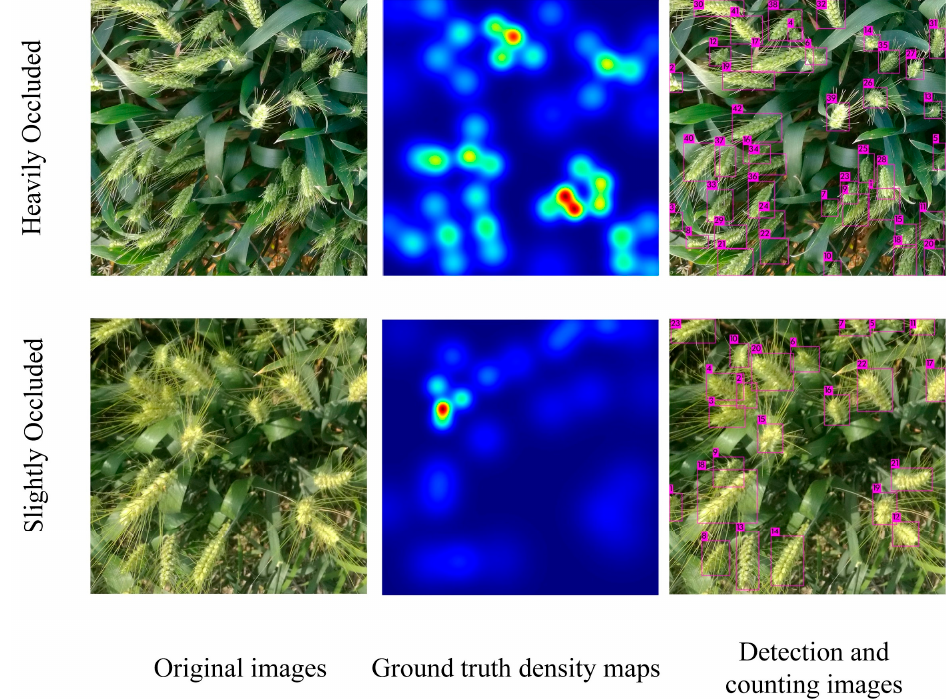
Figure 10. Comparison of detection results of wheat ears with different degrees of occlusion.